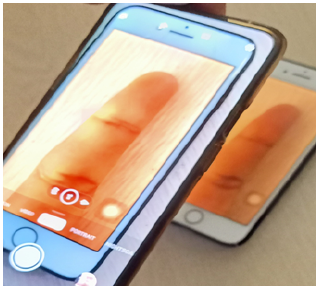
Figure 1. An example of a finger photo display attack. A finger photo of the genuine identity is displayed by using a smartphone positioned in front of the camera integrated in the mobile to unlock.